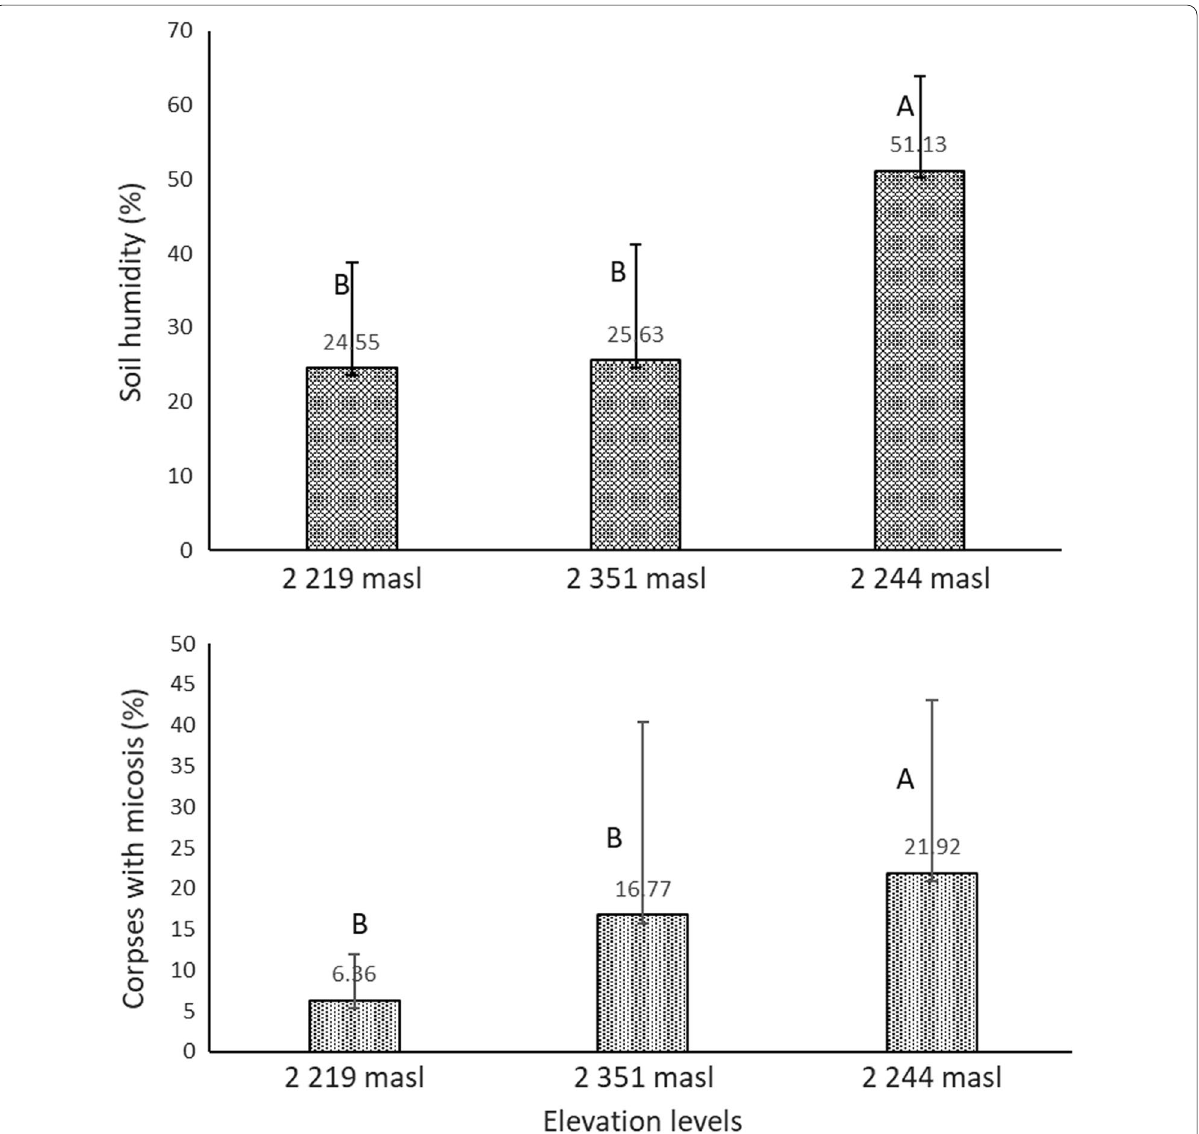
Fig. 5 Corpses with mycosis in the field and its relationship with the soil moisture recorded at the indicated elevation levels. Bars within each graph with the same letter do not differ statistically (Tukey, 0.05). The lines on the bars correspond to the standard